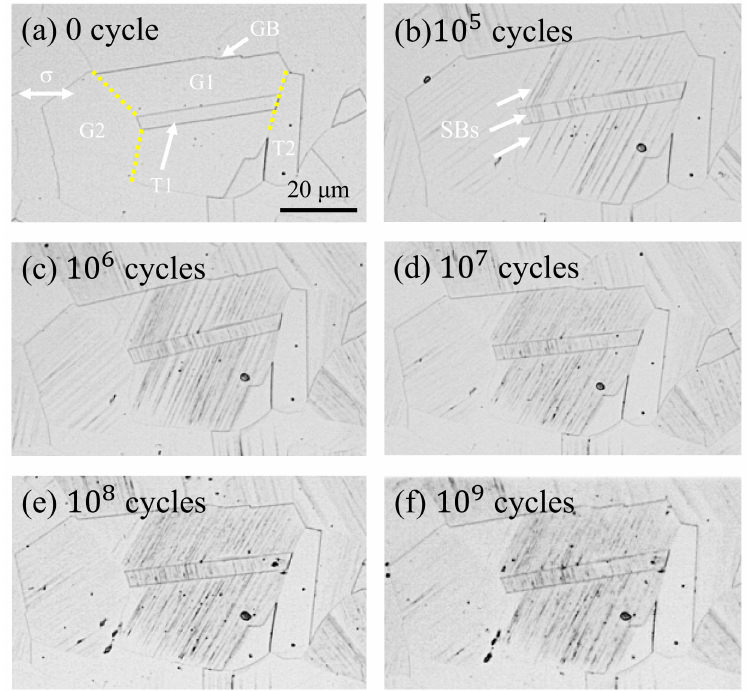
Figure 5. Evolution of slip bands on specimen surface observed by OM. ( a – f ) The number of bending cycles is 0, 10 5 , 10 6 , 10 7 , 10 8 and 10 9 , respectively. ( σ = 322